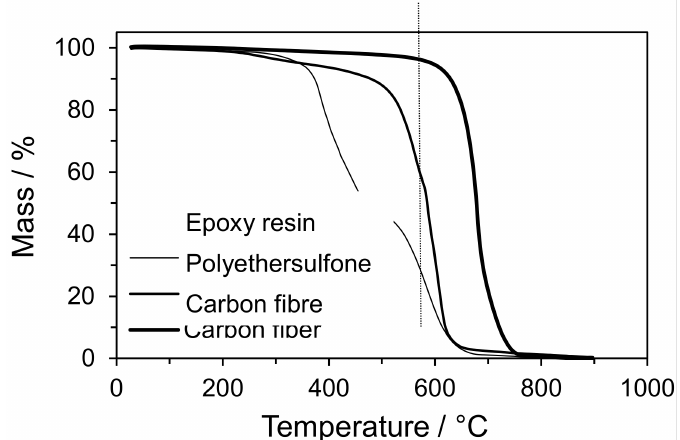
Figure 7. Thermogravimetric analysis of the separated components of the used CFRP. (Air tempera- ture of 580 ◦ C for ablation experiments is